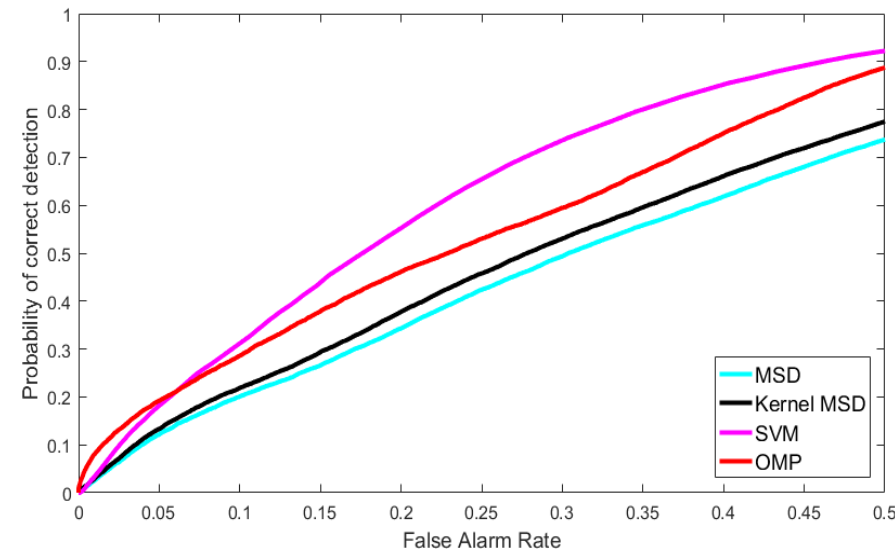
Figure 9. Performance of using color images for soil detection.